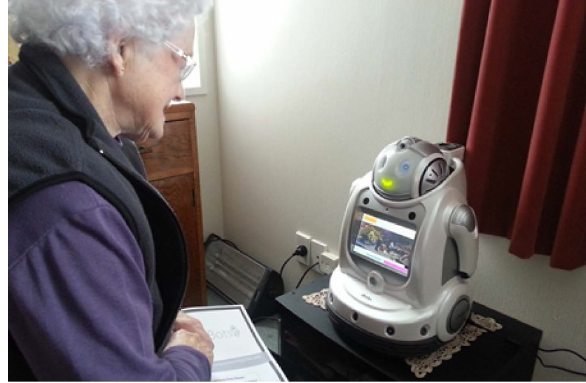
Figure 4: Establishment of ’gaze’ from [19].